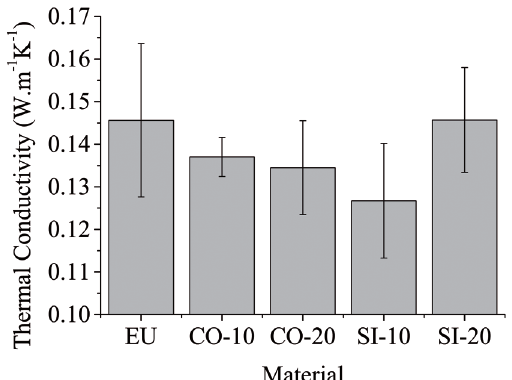
Figure 7: Histogram of the mean values of thermal conductivity. Bars indicate standard deviation